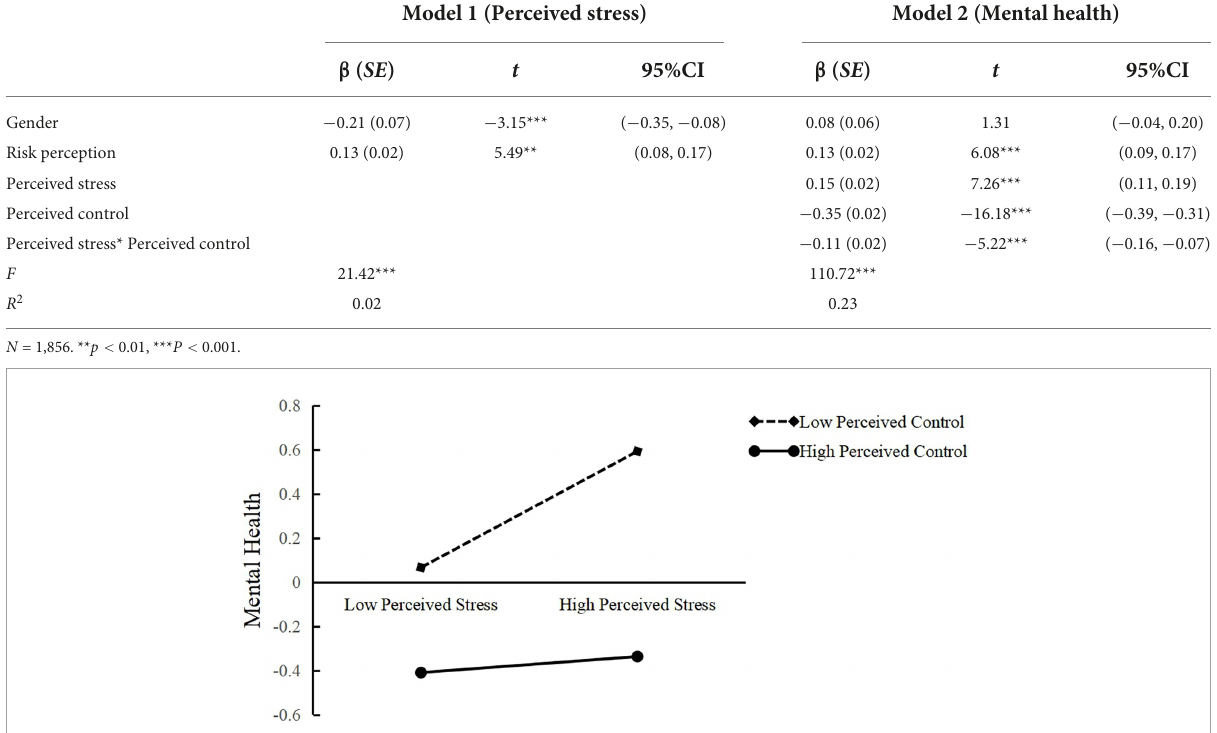
TABLE 2 Path analysis results.